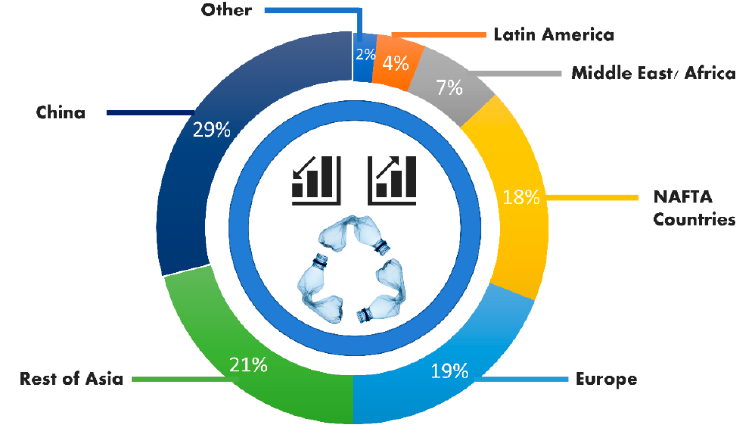
Figure 1. Plastics Statistics in The Oceans (2020) .